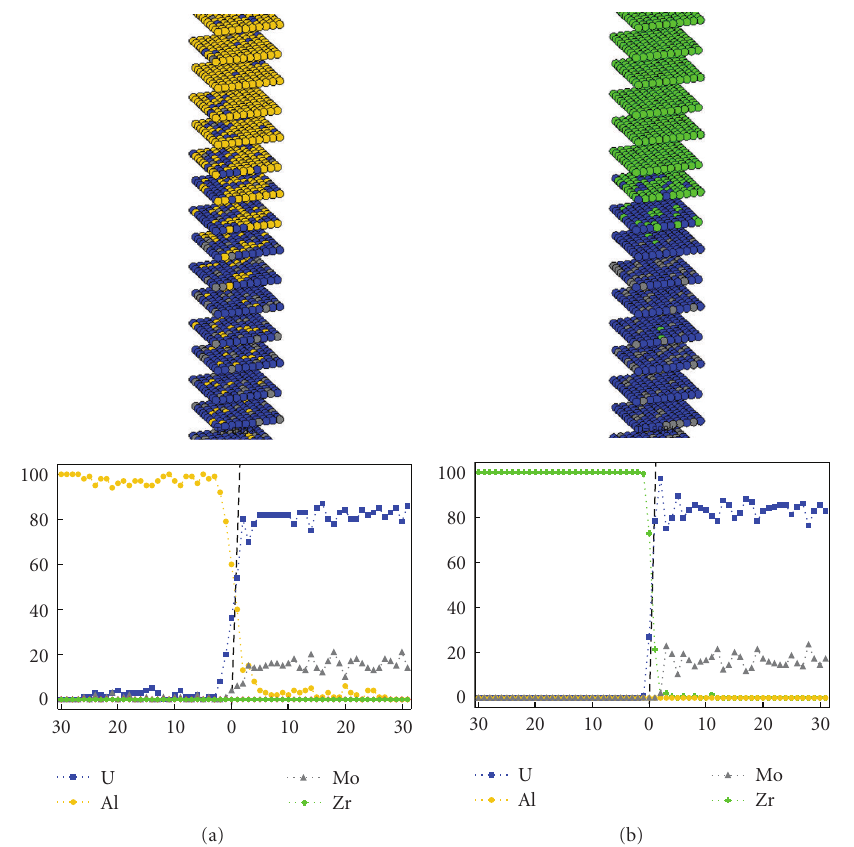
Figure 11: Equilibrium state of the computational cell at T = 800 K for (a) Al/U-7wt% Mo and (b) Zr/U-7wt% Mo, and their corresponding concentration profiles (in wt%). U, Mo, Al, and Zr atoms (and profiles) are denoted in blue, grey, yellow, and green, respectively. The original location of the interface (at the onset of the simulation) corresponds to the label “0”.